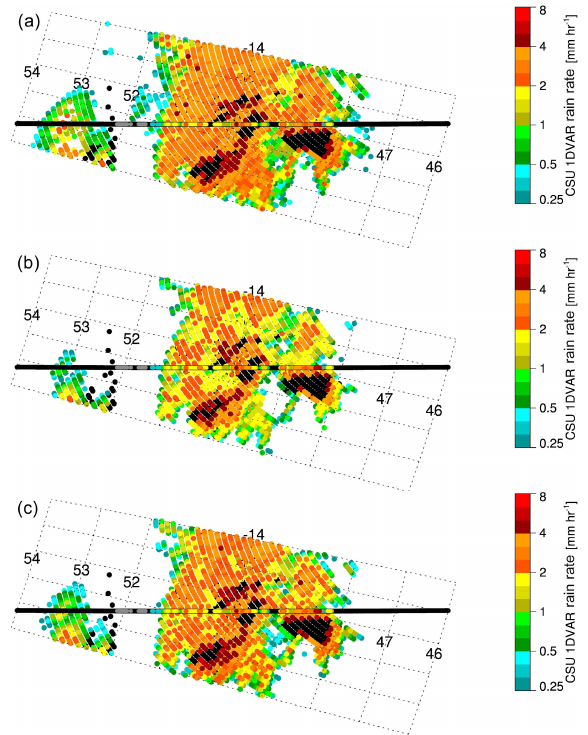
Figure A1. Sensitivity tests following Fig. 7. The panels show retrieved rain rates from the 1DVAR in cases with (a) LWP drizzle onset threshold decreased 50gm − 2 , (b) increased 50gm − 2 , and (c) using GPROF columnar rain water for the a priori state.